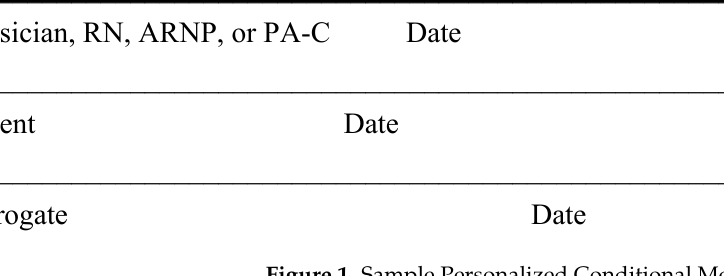
Figure 1. Sample Personalized Conditional Medical Order.